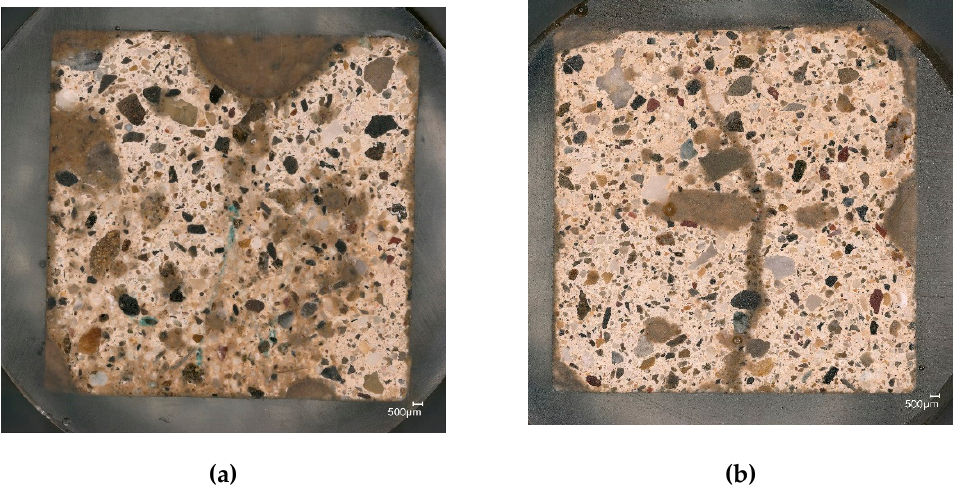
Figure 14. Embedded samples with 0% FC ( a ) and 0.3% FC ( b ) prior to the carbon coating observed